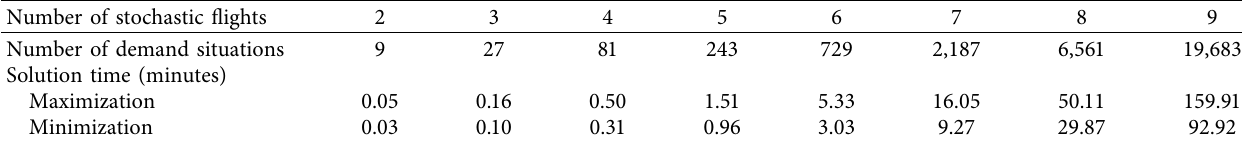
Table 5: Results for different numbers of uncertain demand flights in a